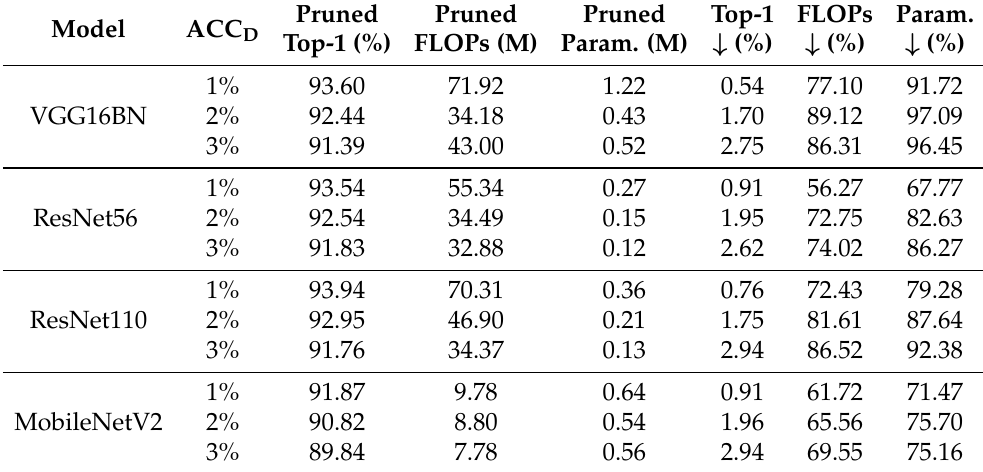
Table 2. Pruning results of the experiment on Cifar10. “Top-1 ↓ ”, “FLOPs ↓ ” and “Param. ↓ ” denote reductions compared to the base networks. The other tables and figures followed the same convention.